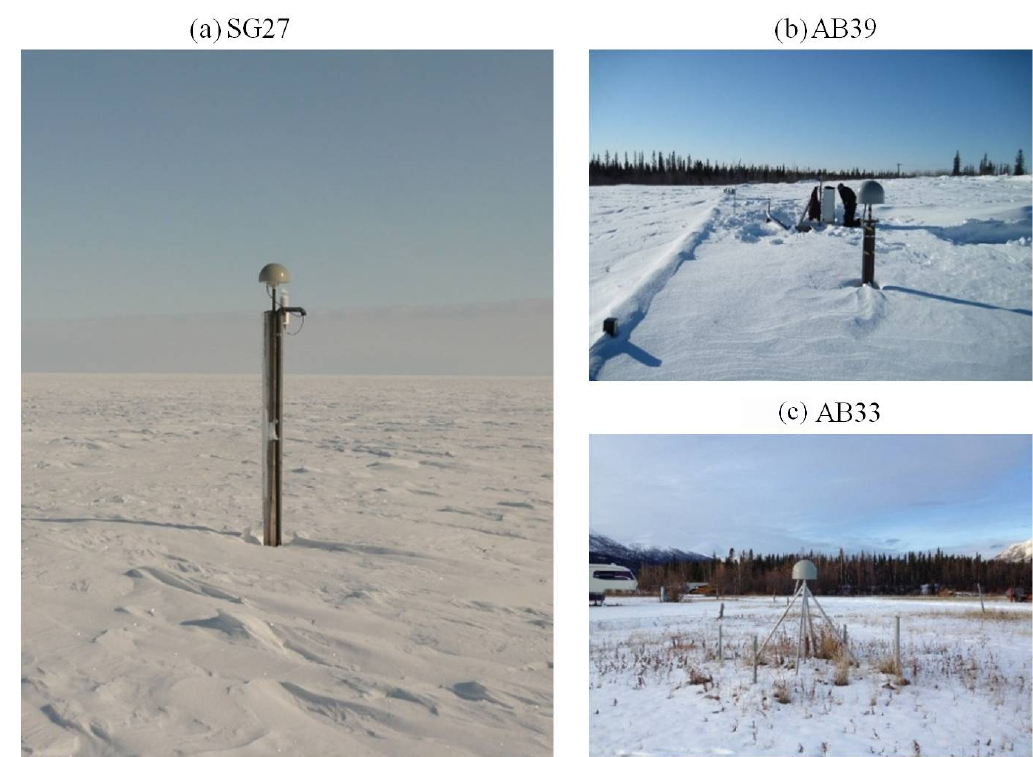
Figure 2. Antenna of three GPS stations SG27 ( a ); AB39 ( b ) and AB33 ( c ).